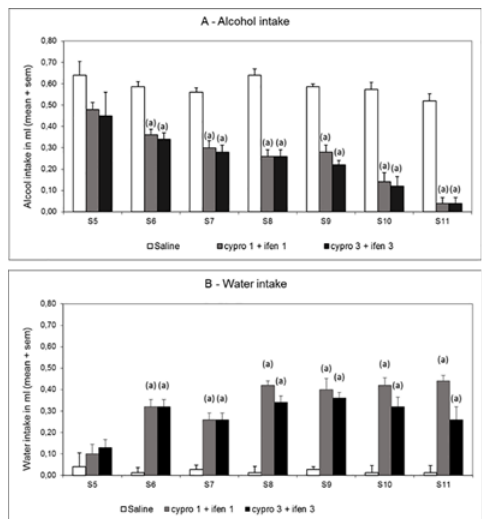
Fig 3. Effect of ifenprodil (ifen) and cyproheptadine (cypro) in combination on alcohol intake (Fig 3A) and on water intake (Fig 3B) during 2 hour sessions with alcohol (10%) and water bottles. Animals were previously exposed for 10 days to forced alcoholic consumption. Ifenprodil and cyproheptadine are administered 30 min before each alcohol session (from session 5 to session 11), at the doses of 1 mg/kg or 3 mg/kg (ifen/cypro 1/1 and ifen/cypro 3/3) (Saline group, N = 15; Cypro 1 + Ifen 1 and Cypro 3 + Ifen 3 groups, N = 10). Statistical analyses: repeated measures ANOVA, alcohol intake, group effect F 2;32 = 299.1, p < 0.001, session effect F 7;224 = 17.4, p < 0.001, group × session interaction F 14;224 = 3.0, p < 0.001; water intake, group effect F 2;32 = 108.5, p < 0.001, session effect F 7;224 = 12.4, p < 0.001, group × session interaction F 14;224 = 4.5, p < 0.001; one-way ANOVAs, differences between groups in session 5, alcohol intake, F 2;32 = 2.0, p = ns; water intake, F 2;32 = 2.1, p = ns; in sessions 6 – 12, F 2;32 (cid:1) 11.0, p < 0.001; post-hoc comparisons, Dunnett test, (a) significantly different ( p < 0.05) from saline group.